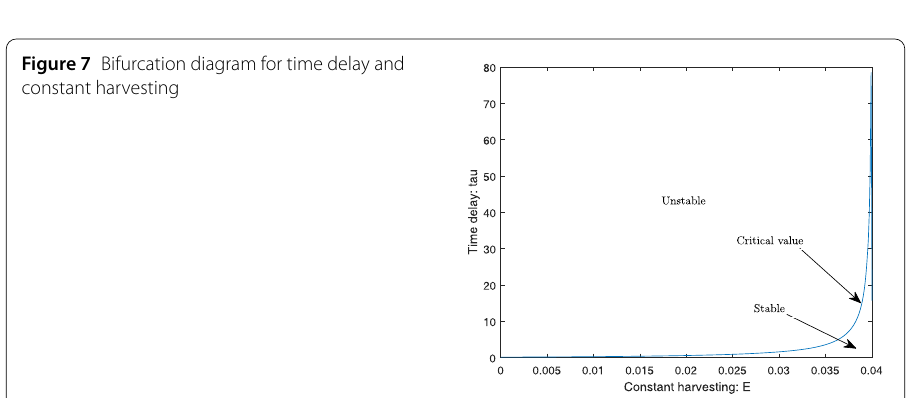
Figure 6 The numerical simulations of system (1.2)